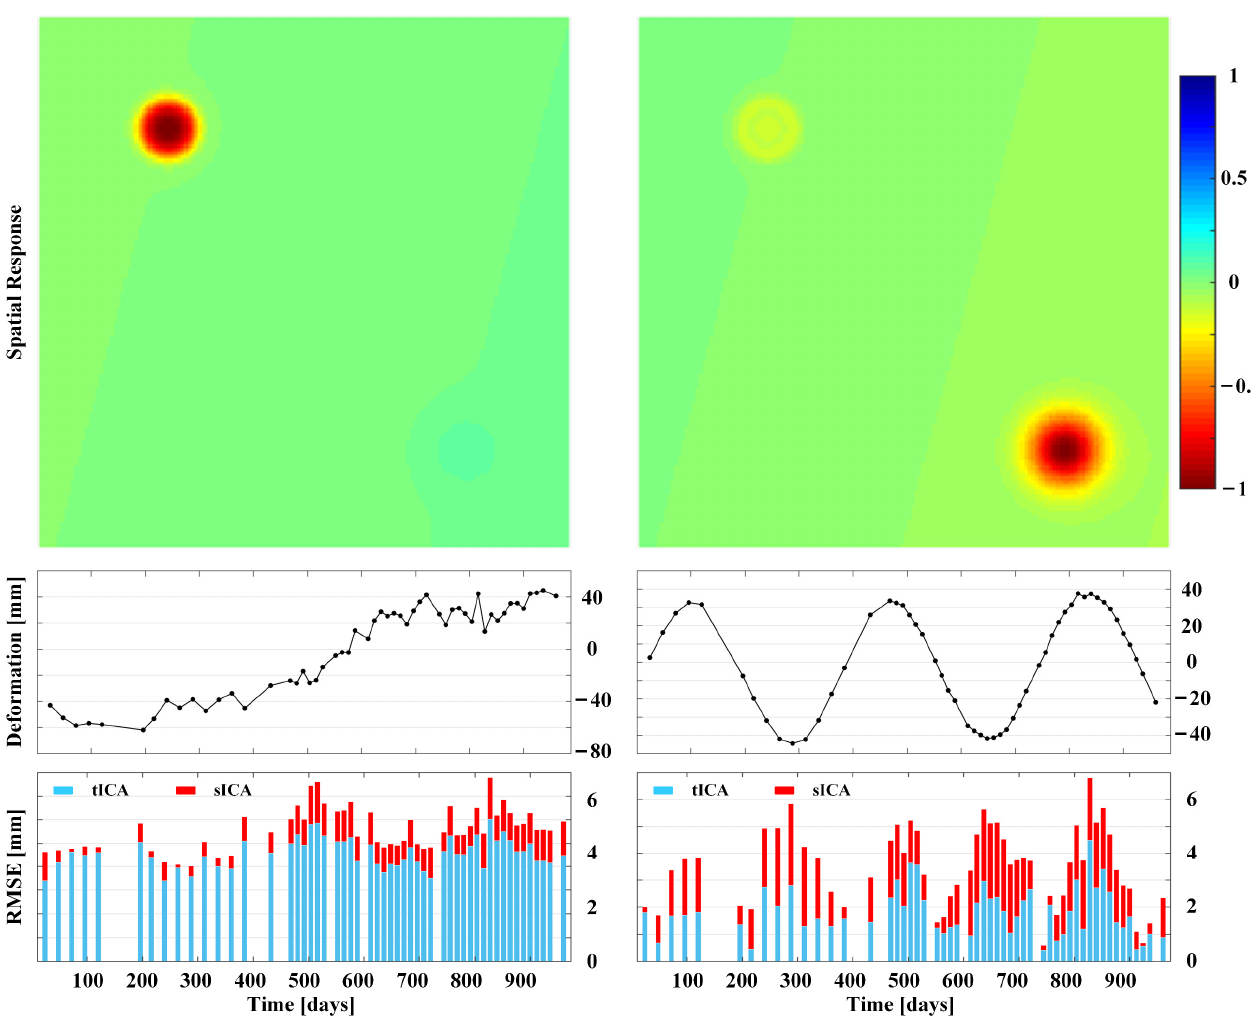
Figure 3. ICA separated results ( top ‐ left : spatial response of Poisson ‐ related components, and top ‐ right : spatial response of periodic deformation components; middle ‐ left : time series of Poisson ‐ related components and middle ‐ right : time series of periodic deformation components; bottom ‐ left : comparison of tICA and sICA ‐ separated results of Poisson ‐ related components at each temporal point; bottom ‐ right : comparison of tICA and sICA separation results of periodic deformation components at each temporal point (the length of each blue histogram represents the RMSE value of tICA, whereas the top red one represents that of sICA).